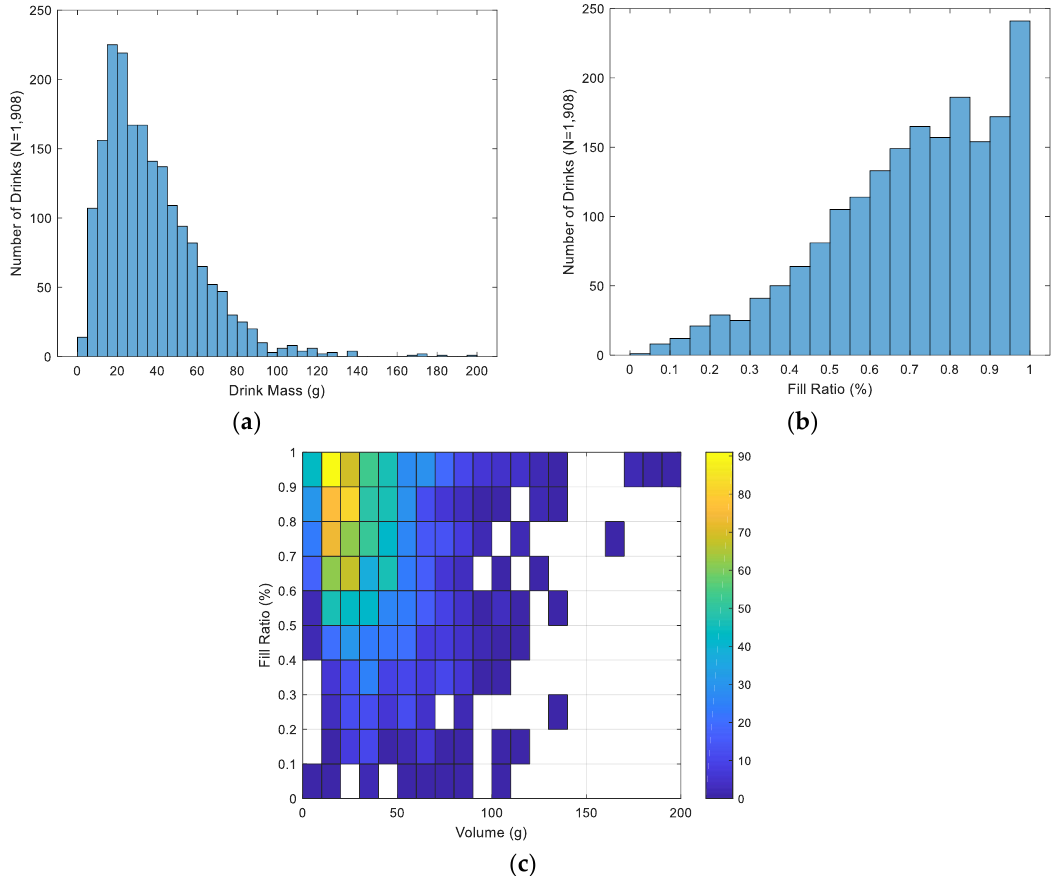
Figure 2. ( a ) Univariate distribution of drink masses; ( b ) univariate distribution of fill ratios; ( c ) joint distribution of masses and fill levels.